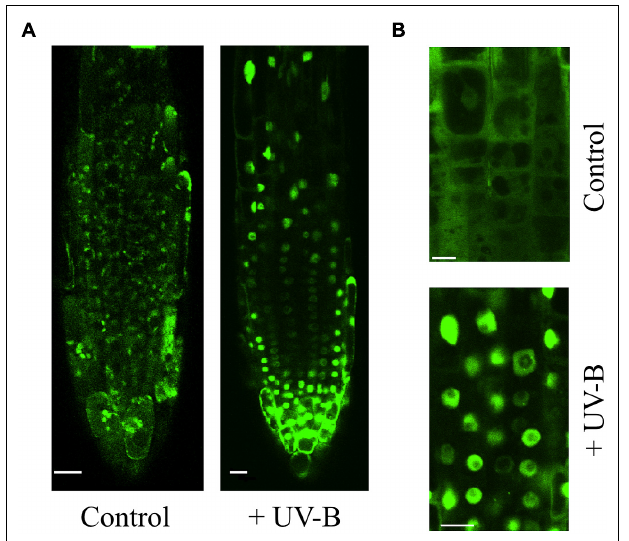
FIGURE 2 | Relocation of UVR8::GFP to nuclei in Arabidopsis root cells. (A) Root apex region. (B) Magnified view of cells in the transition zone. Bar indicates 10 μ m. Arabidopsis roots were exposed to 1 h UV-B treatment (3.9 μ mol m − 2 s − 1